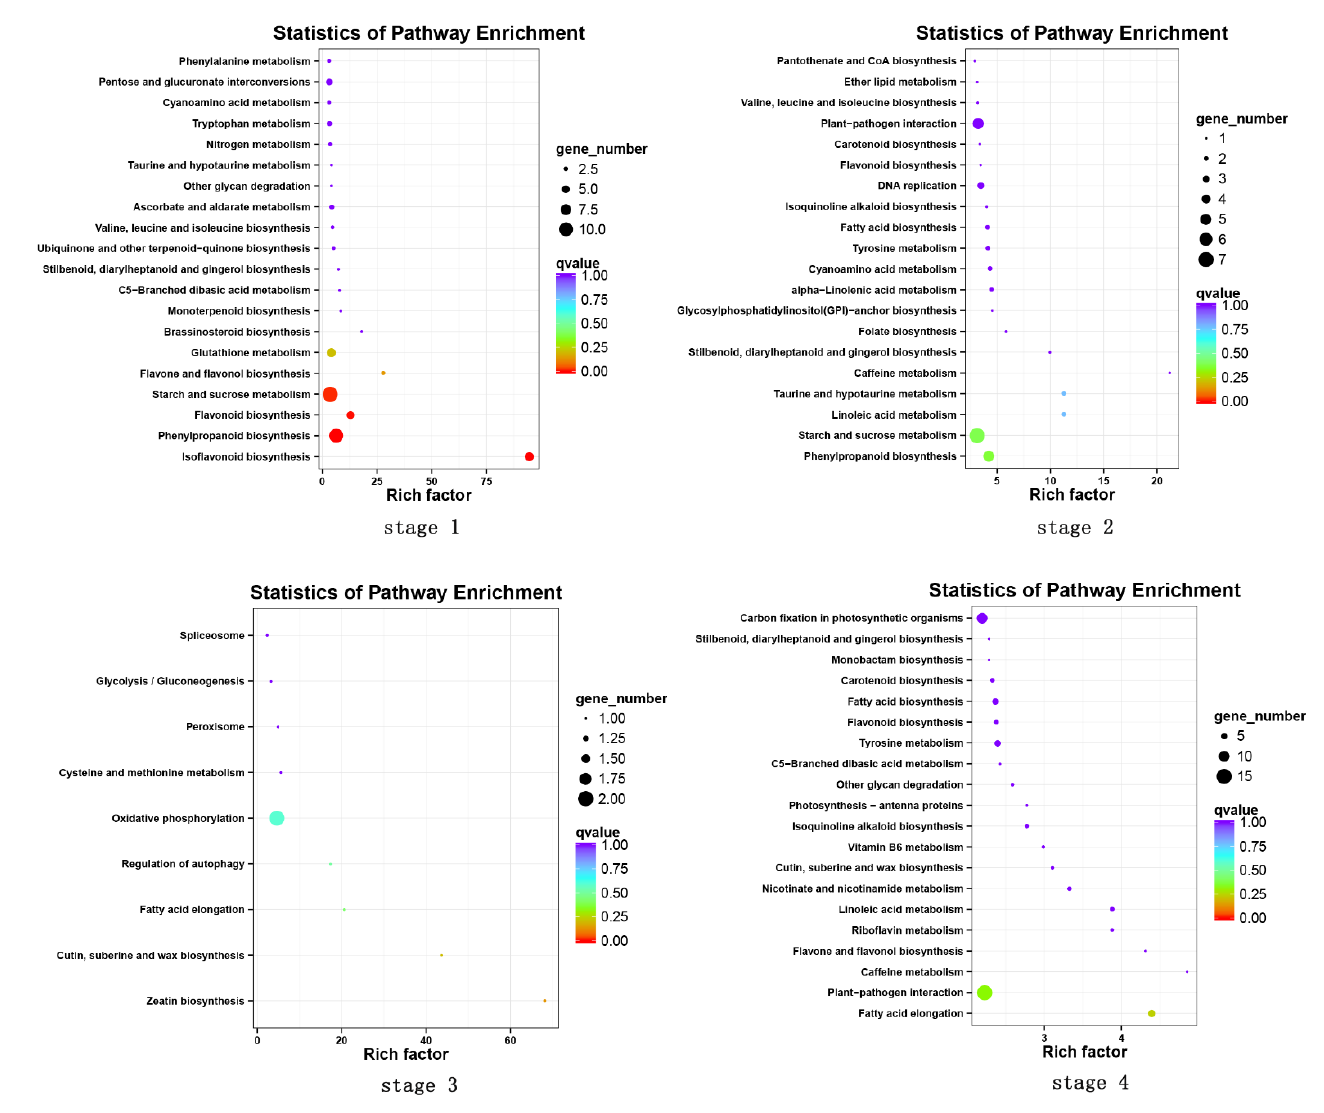
Figure 5. Scatter plot of KEGG pathways of the differentially expressed genes